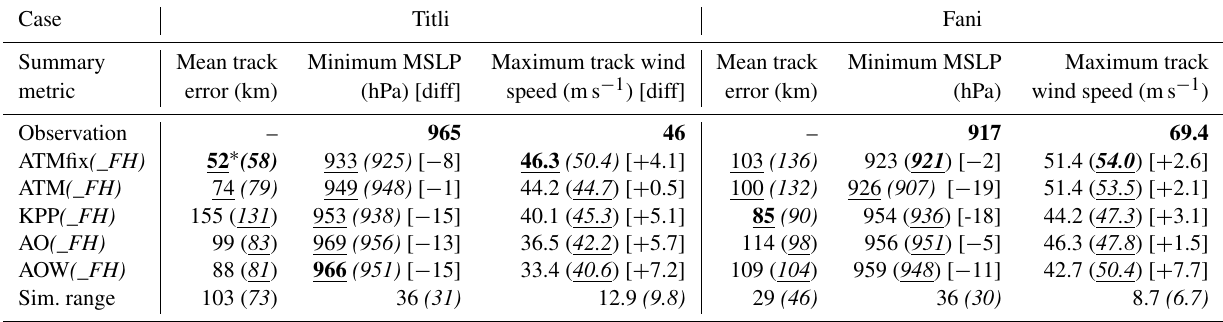
Table 8. Summary of observed and simulated cyclone statistics for Titli and Fani cases. Figures in round bracket italics indicate results from simulations with frictional heating enabled, with differences listed in square brackets. Underlined values indicate which of the simulations with or without frictional heating give the closest metric to observed data for a given run type. Bold values indicate which simulation has the best metric across all experiments conducted. The final row summarizes difference between highest and smallest simulated values. ∗ ATMfix cyclone tracking identified the cyclone later than for other